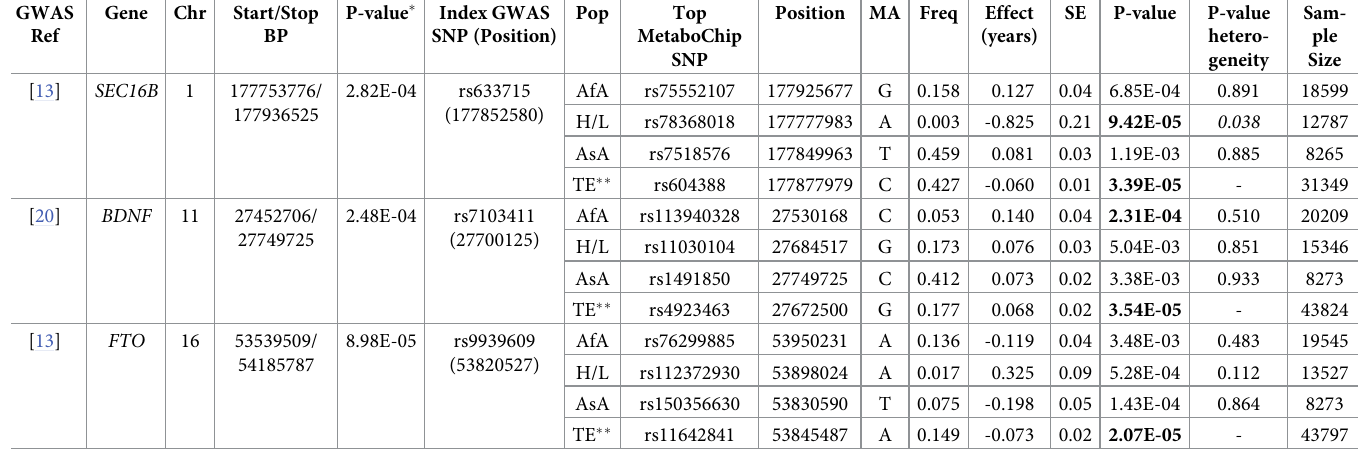
Table 3. Three densely-genotyped MetaboChip loci with Bonferroni-significant associations with age at menarche across multiple race/ethnic groups or trans- ethnically. GWAS Ref